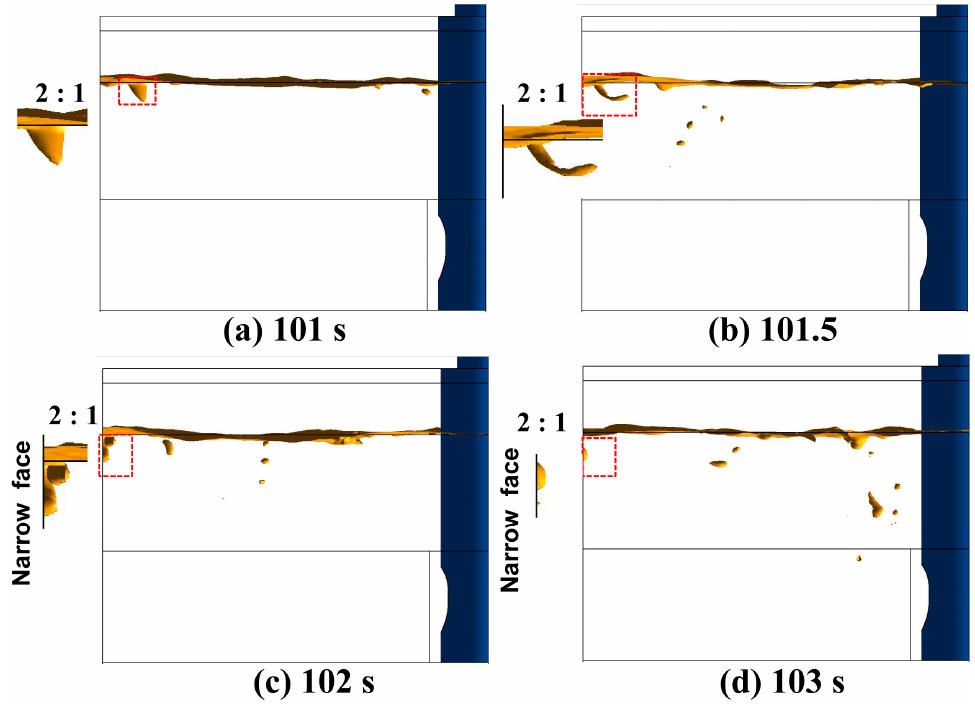
Figure 9. Transient deformation of after ( a ) 101 s, ( b ) 101.5 s, ( c ) 102 s, and ( d ) 103 s.